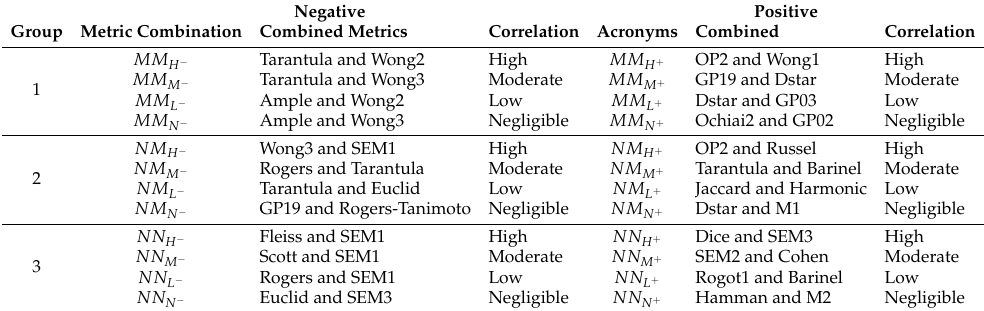
Table 4. Details of selected combined risk evaluation metrics based on correlation.